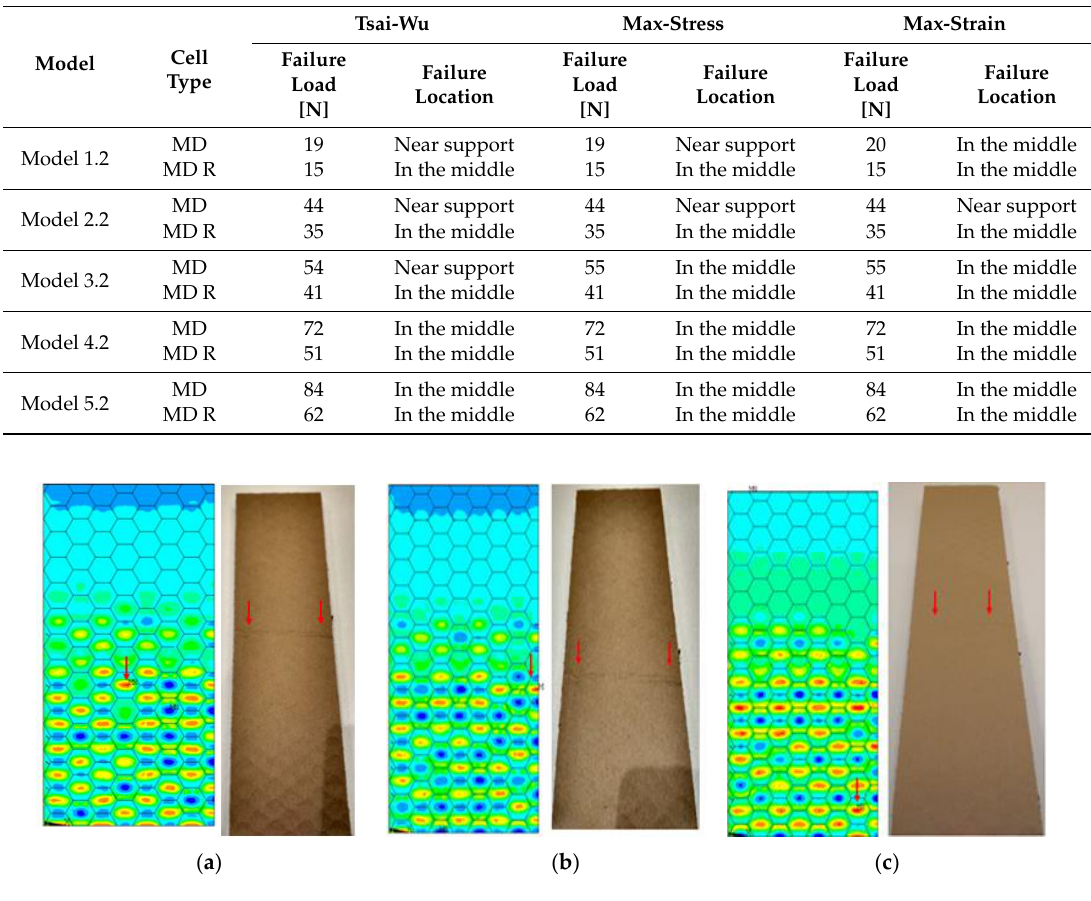
Figure 16. Comparison of failure places in MD: ( a ) H = 8 mm ( b ) H = 18 mm ( c ) H = 28 mm. Table 5. Comparison of failure loads and locations for models in MD.